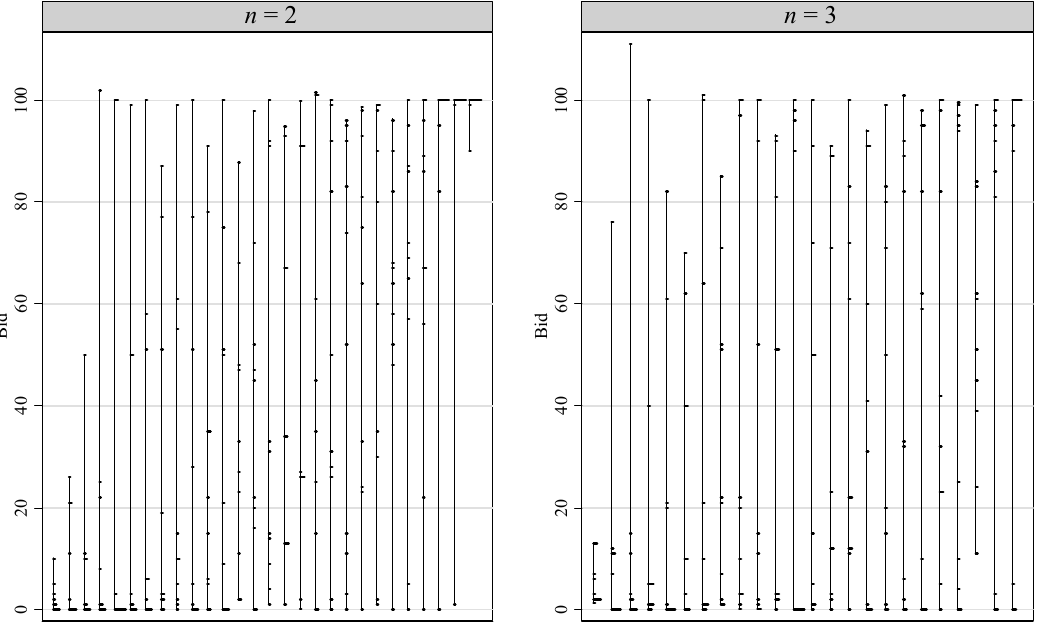
Figure 3. Individual histograms of the bids in the ten rounds of the Recall treatment.